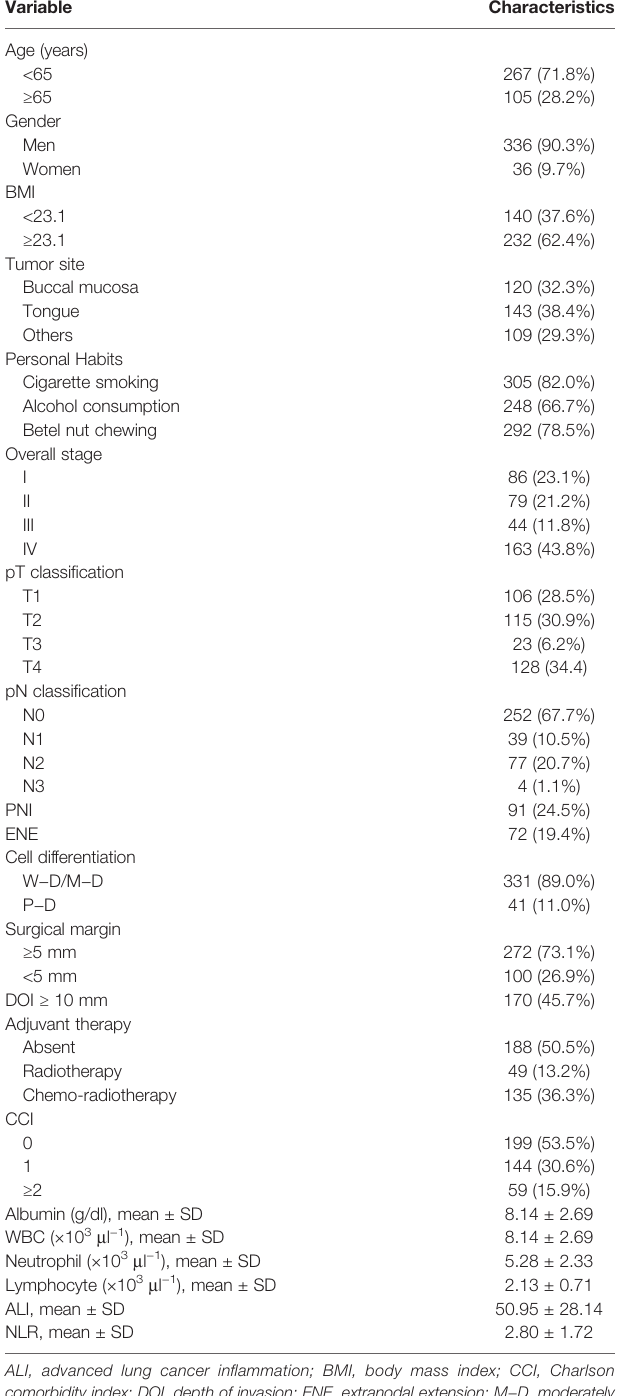
TABLE 1 | Baseline clinicopathological characteristics of patients with oral cavity squamous cell carcinoma ( n = 372).